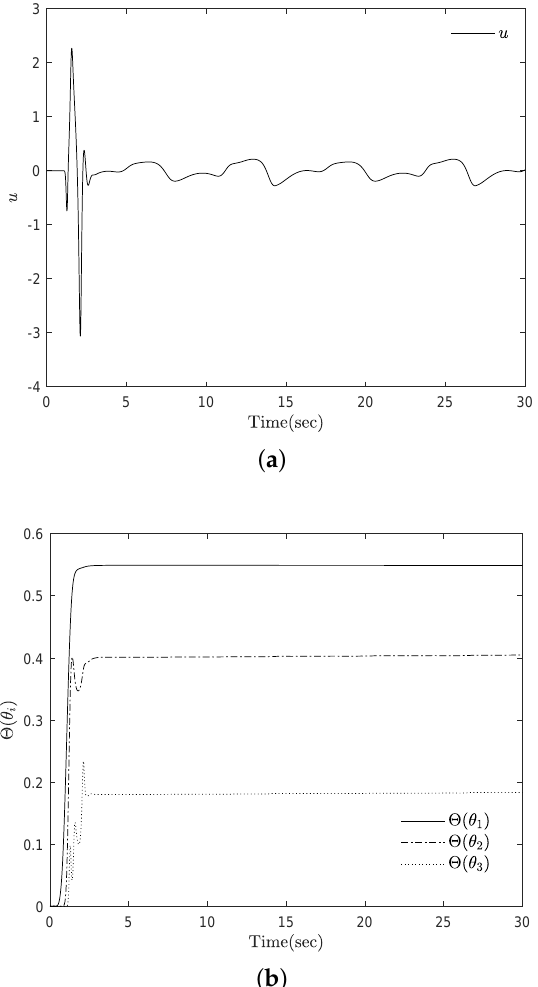
Figure 3. The control input and the Nussbaum functions’ outputs for Example 1: ( a ) u ; ( b ) Θ ( θ i ) , i = 1,2,3.